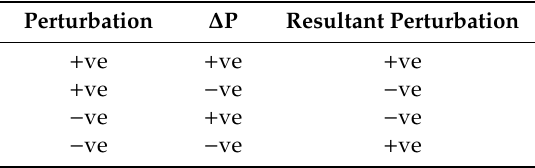
Table 1. Perturbation summary for the P&O algorithm.